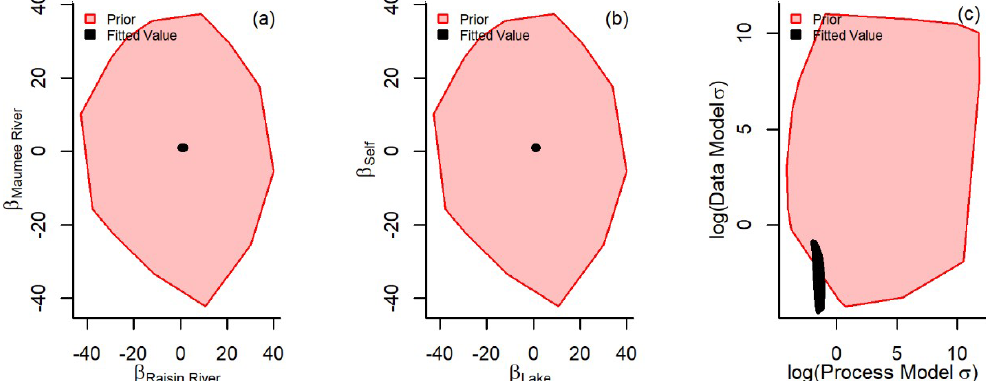
Figure C1. Non-informative priors were used to fit the state-space coefficients of the Maumee River ( β mau , a all values represented as red polygons), Raisin River ( β ras ), the western Lake Erie nodes subject to movement ( β lake , b red polygons), and those Lake Erie nodes which did not encounter sufficient water movement to associate with an “upstream” node ( β self ). The fitted values for every year ( a and b , all values represented as black polygons) do not appear to be overly influenced by the uninformed priors. The log data model and process model uncertainty (c) for every year were also well identified (the uncertainty σ was logged to aid in visually comparing prior and fitted